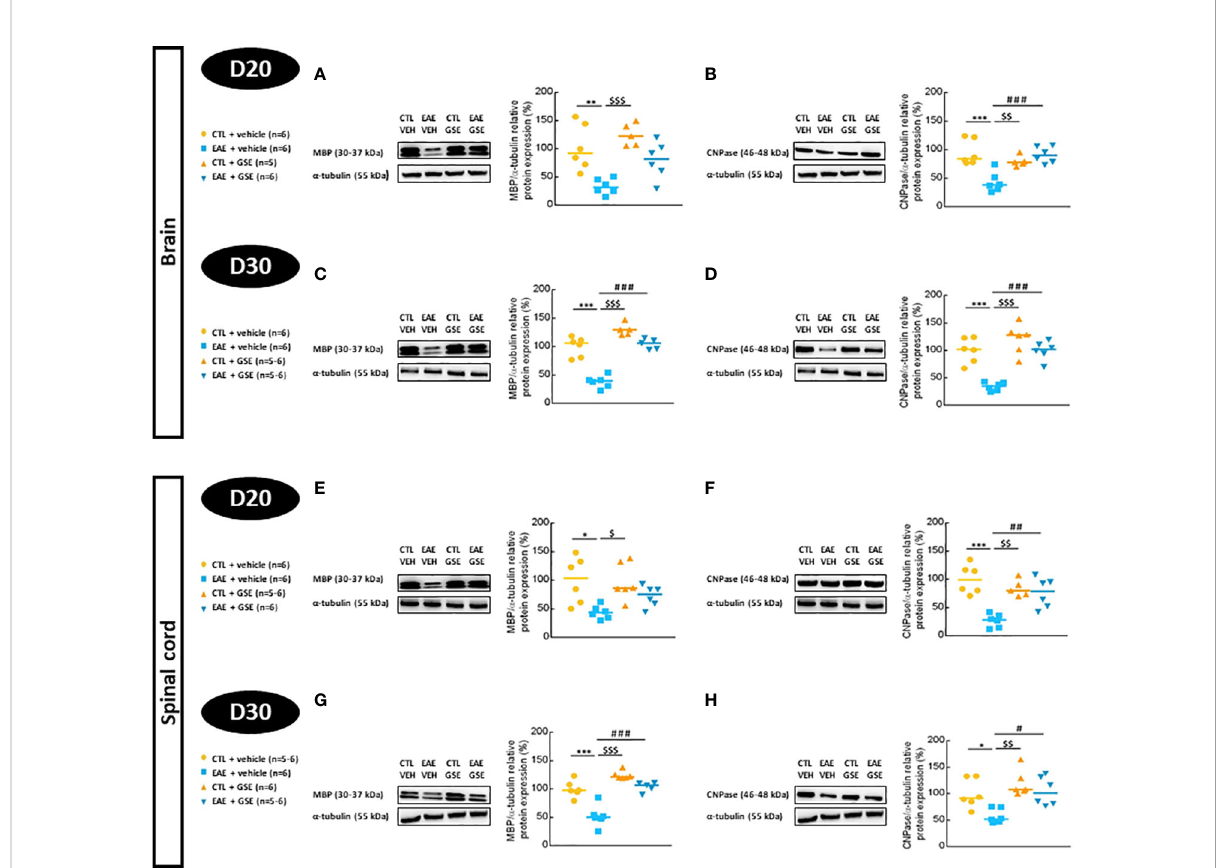
FIGURE 7 Evaluation of myelin basic protein (MBP) and 2 ′ ,3 ′ -cyclic-nucleotide-3 ′ -phosphatidesterase (CNPase) expressions in the brain and spinal cord of experimental autoimmune encephalomyelitis mice (EAE) and their controls (CTL) after curative treatment with grape seed extract (GSE) or vehicle. MBP/ a -tubulin protein expression was expressed as the relative protein expression (%) compared to CTL + vehicle group, in the brain (A, C) and the spinal cord (E, G) at D20 (A, E) or D30 (C, G) post-induction. CNPase/ a -tubulin protein expression was expressed as the relative protein expression (%) compared to CTL + vehicle group, in the brain (B, D) and the spinal cord (F, H) at D20 (B, F) or D30 (D, H) post- induction. For each protein level quanti fi cation, a representative Western blotting image of the target protein and loading control is proposed. Statistical analysis was performed using one-way ANOVA followed by Tukey ’ s multiple comparison test: *p < 0.05, **p < 0.01, ***p < 0.001 EAE + vehicle vs CTL + vehicle; #p < 0.05, ##p < 0.01, ###p < 0.001 EAE + GSE vs EAE + vehicle and $p < 0.05, $$p < 0.01, $$$p < 0.001 EAE + vehicle vs CTL +